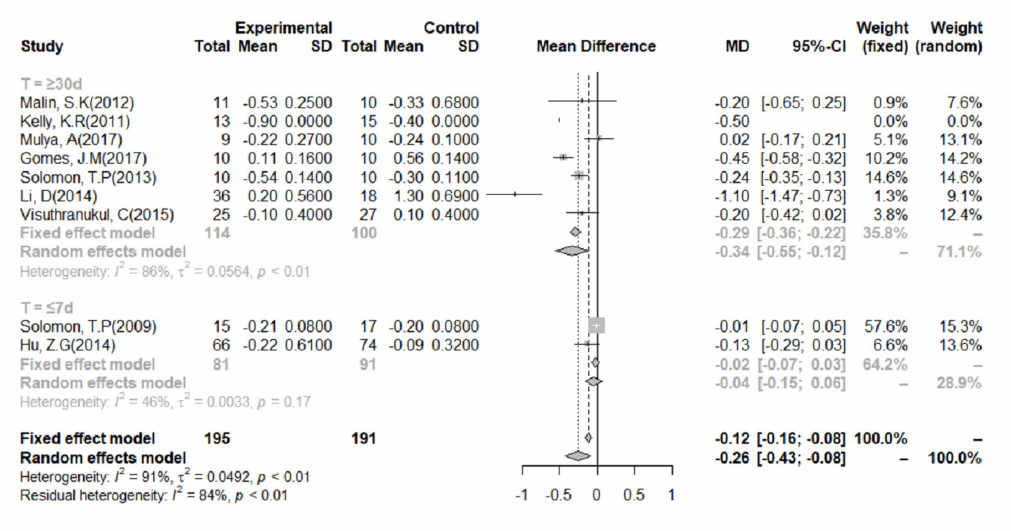
Figure 5. Meta-analysis of the effect of a low-glycemic index diet on fasting blood glucose concentra- tion, categorized according to the duration of the study. A random-effects model and mean difference analysis were used.